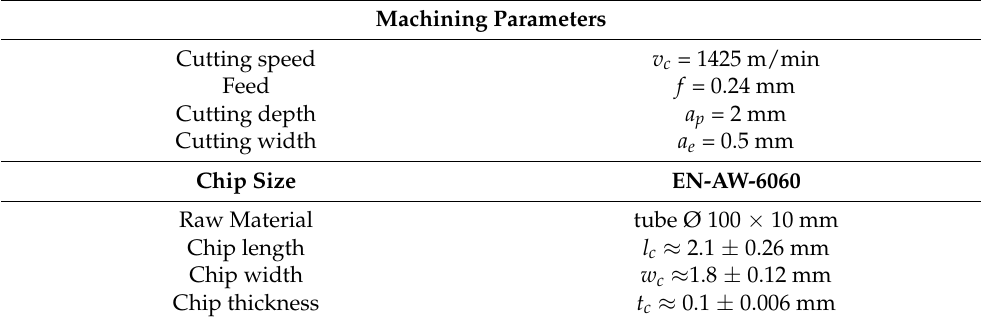
Table 1. Machining parameters for the production and geometric characterization of the chips.